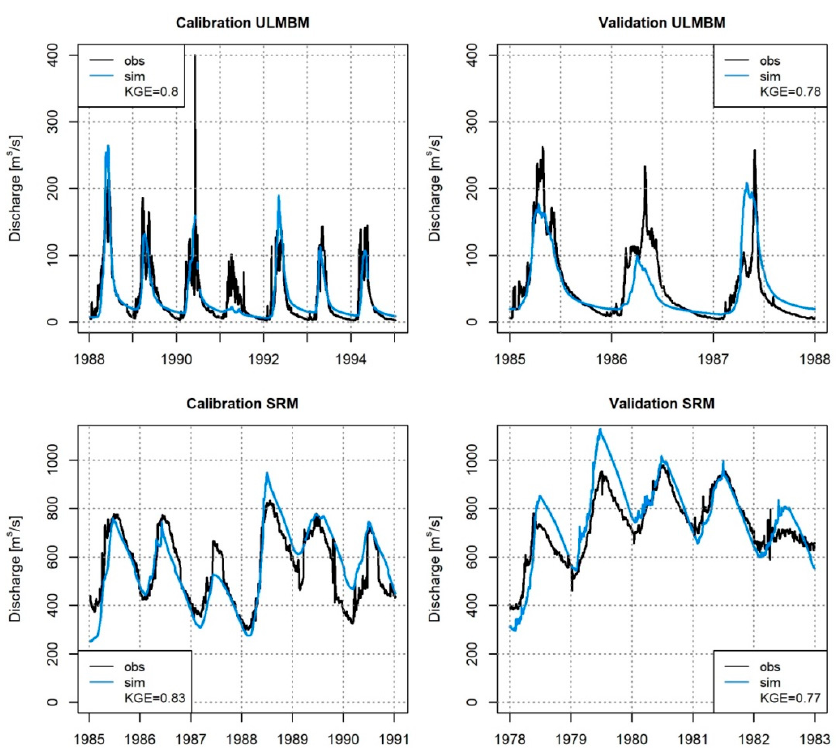
Figure 4. Simulated vs. observed hydrographs for the calibration and verification periods (columns) obtained by the mHM for the Upstream Lake Malawi Basin Model (ULMBM) and the Shire River Model (SRM) (rows).